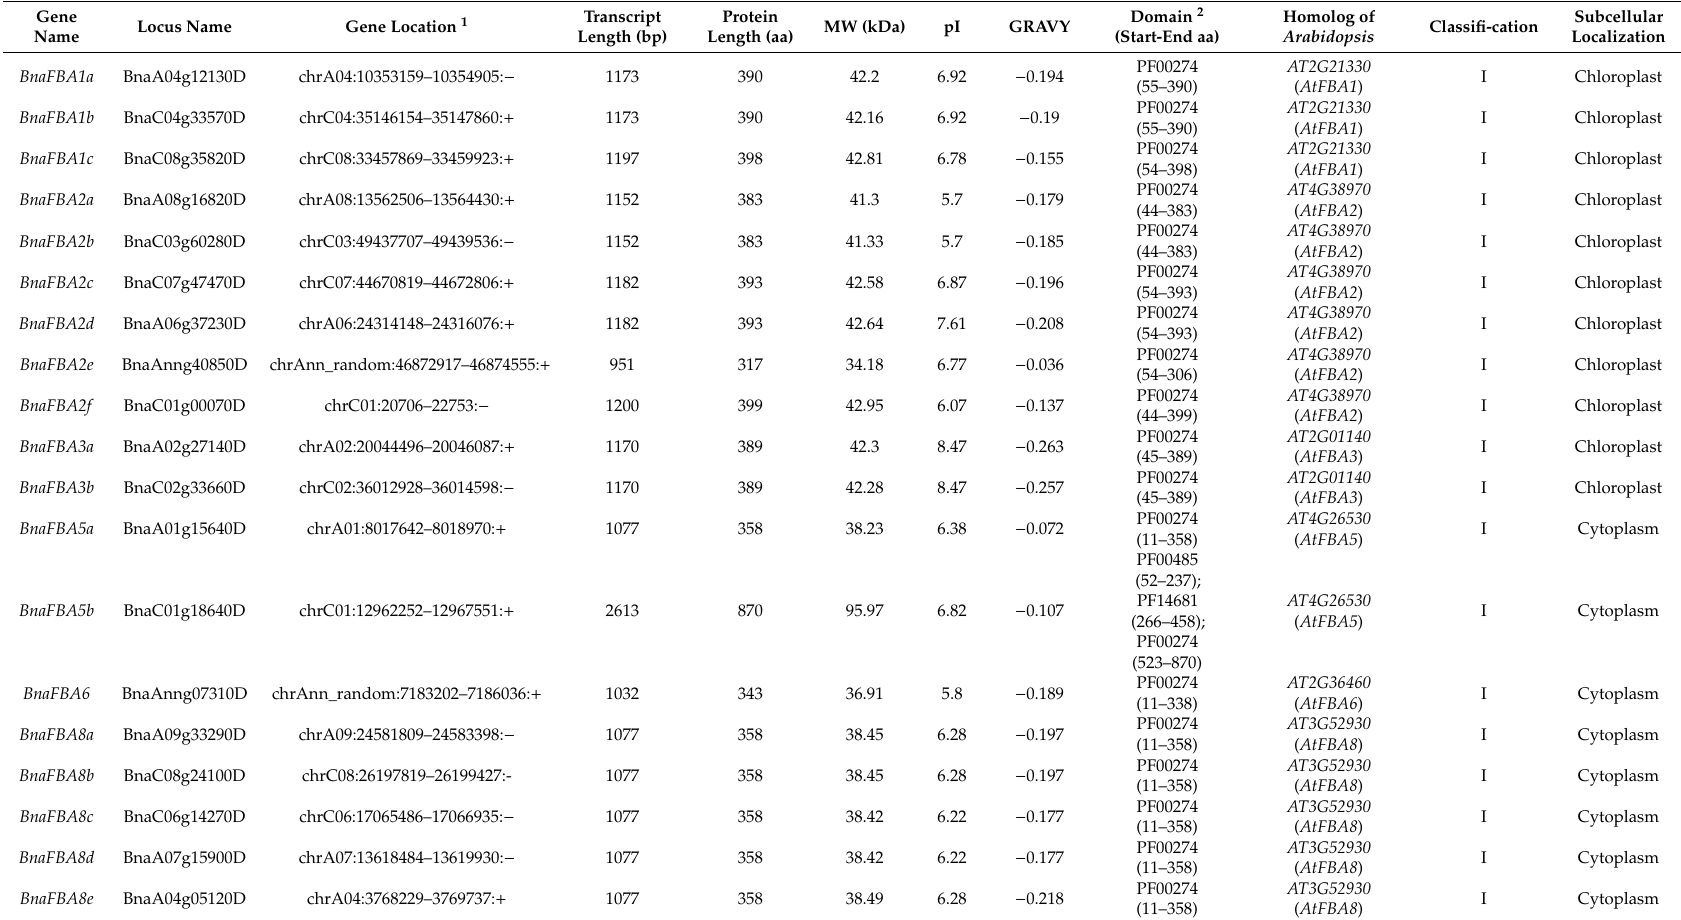
Table 1. Summary Information on FBA Family Genes in B. Napus